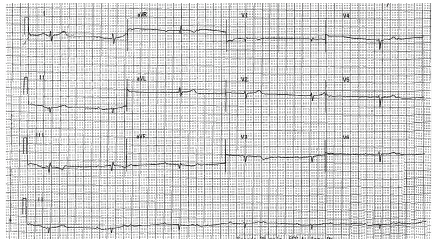
Figure 1: Two : one atrioventricular block in a patient with unstable angina prior to